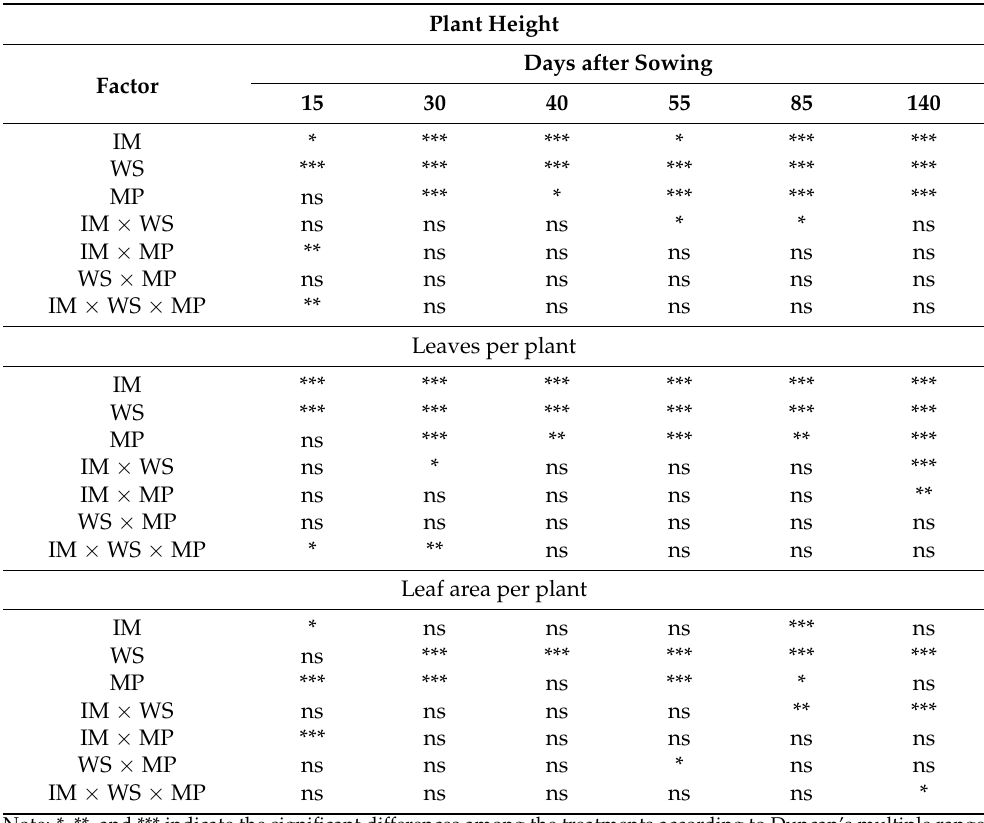
Table 4. ANOVA output for the effect of irrigation methods (IM), water stress (WS), and mulching practice (MP) on mean plant height leaves per plant, and leaf area per plant of grain maize on different days after sowing